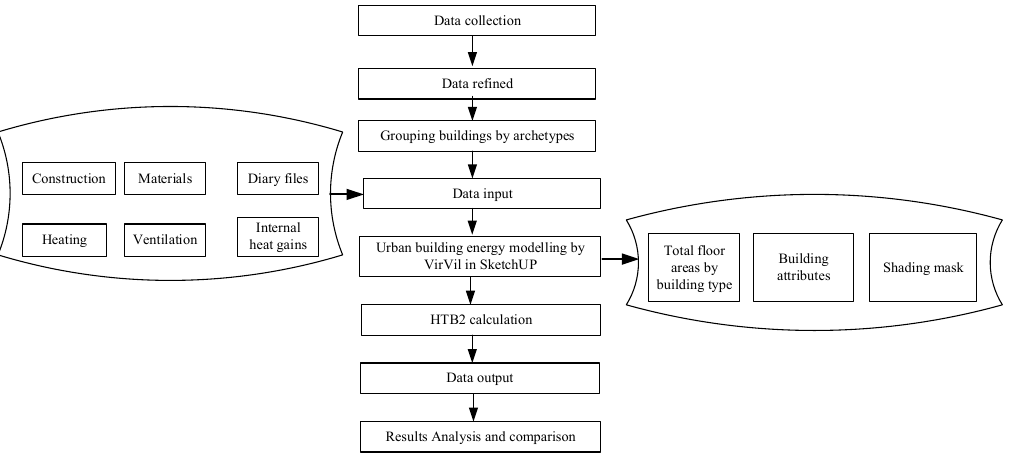
Figure 3. Research flow of this